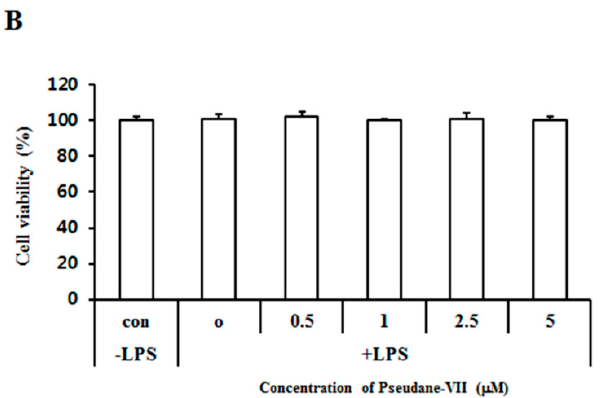
Figure 1. Structure of pseudane-VII and cytotoxic effect in BV-2 microglial cells. ( A ) Structure of pseudane-VII. ( B ) BV-2 microglial cells (1 × 10 4 cells/well) were seeded at 96-well culture plates and